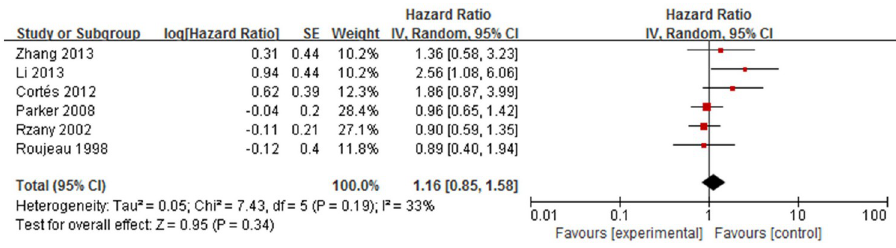
Fig 7. Forest plot of the association between sex and bullous pemphigoid mortality.